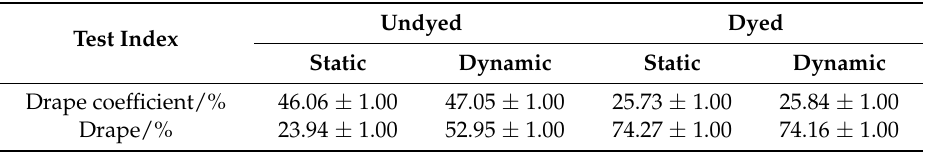
Table 6. Drape properties of warp-knitted Table 6 Drape properties of warp-knitted fabrics.